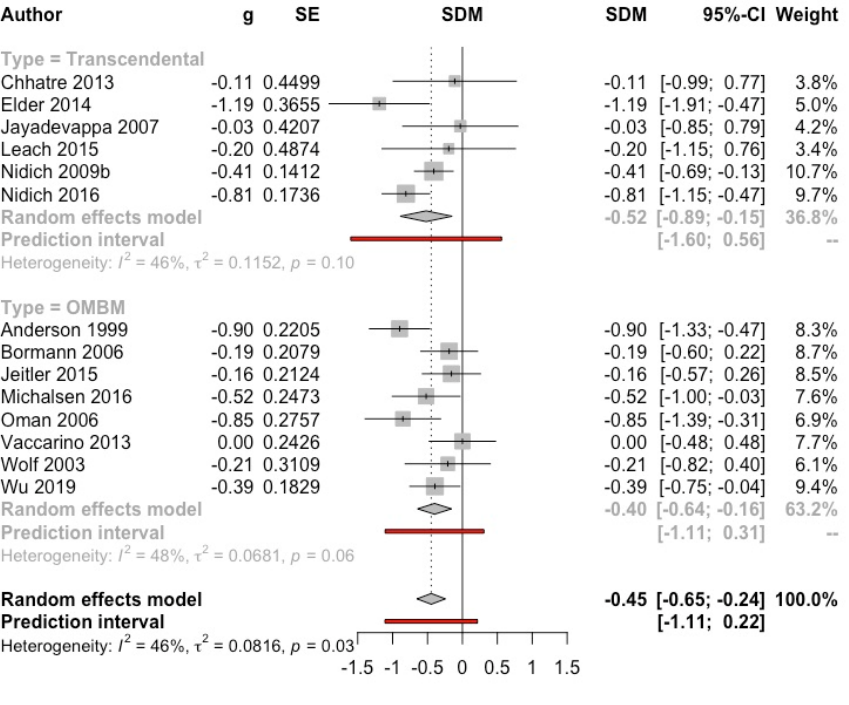
Figure 6. Effect on stress (meditation vs. control). Predictive intervals are represented in red.